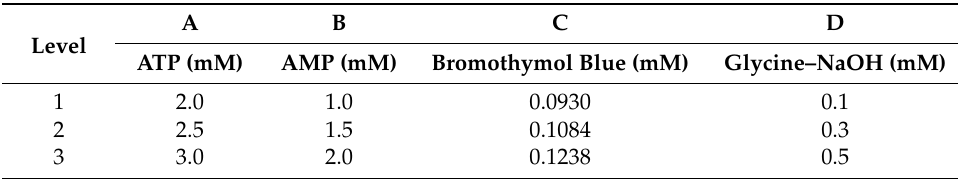
Table 1. Factors and levels affecting Adk activity assay.